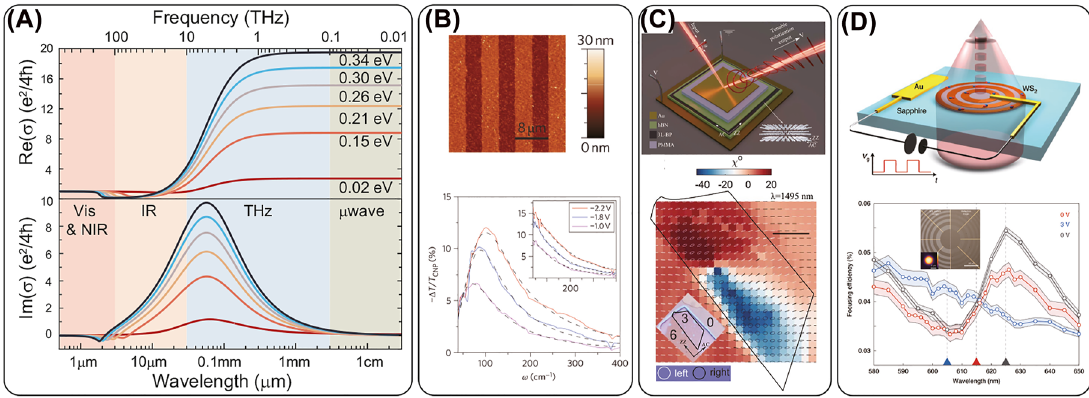
Figure 5: (A) Bias dependent conductivity of graphene over the electromagnetic spectrum from microwave to visible wavelengths. The O underneath the graphene layer and an initial doping of 5 × 10 10 cm − 2 from conductivity is calculated with an assumption of 50 nm Al 2 3 defects. (B) Graphene based plasmonic metasurfaces. Top: AFM image of a fabricated micro-ribbon array of graphene (light colors) on top of silicon dioxide (dark colors), each of 4 μ m width. Scale bar is 8 μ m. Bottom: Plasmonic resonance varied with electrical gating. The inset shows the response with polarization along the ribbons. Reprinted from [151], Copyright 2011, Springer Nature. (C) Polarization conversion on a tri-layer black phosphorus. Top: Schematic of an electrically tunable metasurface with polarization conversion. Bottom: A spatial color map of ellipticity at 1495 nm with reflected polarization ellipses varying from point to point. The inset shows the optical image of the device. The outlined region covers the tri-layer BP. Reprinted from [152], Copyright 2021 AAAS. (D) Top: Schematic of an electrically tunable WS 2 zone plate lens. Bottom: Focusing efficiency spectra of the lens under different bias. The shaded area shows the error bar corresponding to one standard deviation. The inset shows the optical microscope image of the center of a fabricated lens (right) and the designed WS 2 pattern. Reprinted from [153], Copyright 2020, Springer